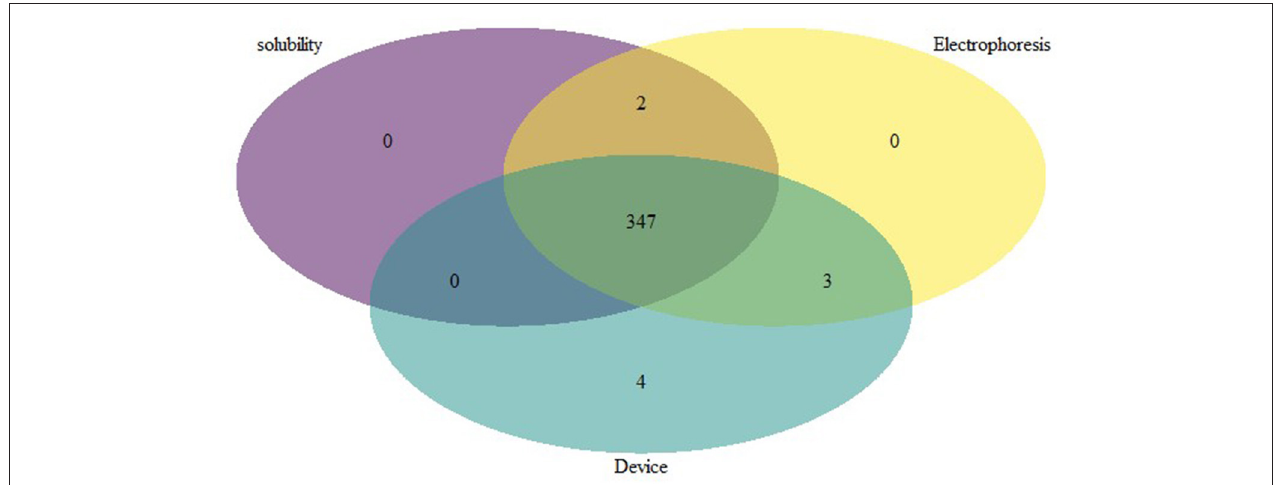
FIGURE 3 | Venn diagram depicting the comparative performance of different sickle diagnostic tests. The overlap result of diagnostic test showed that 347 samples with HbS were found to be positive in all 3 different tests.